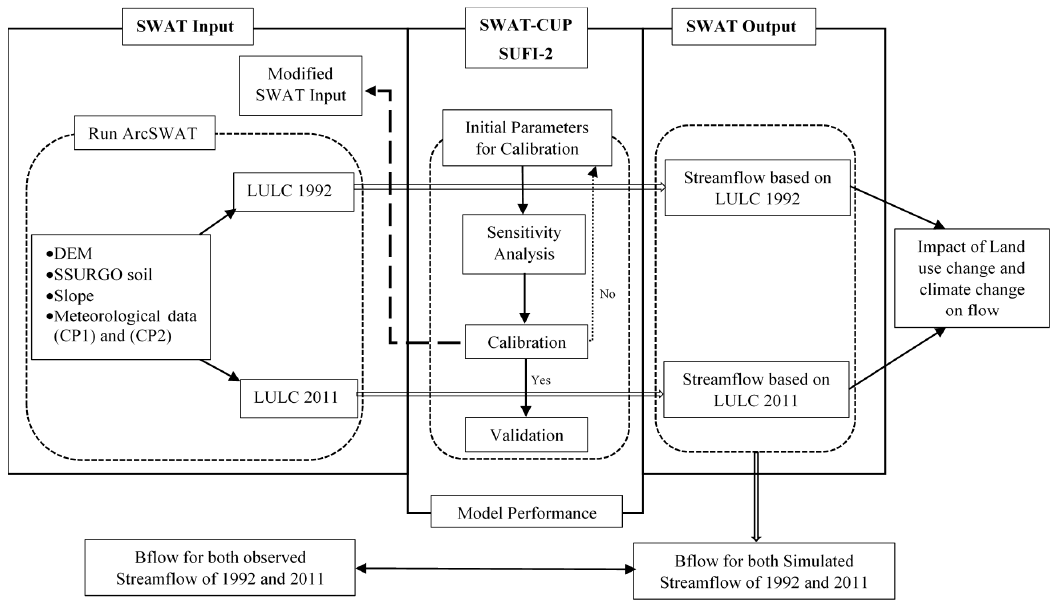
Figure 2. Flow chart depicting procedure for SWAT model setup, calibration and validation of both streamflow and baseflow in the LEC watershed.